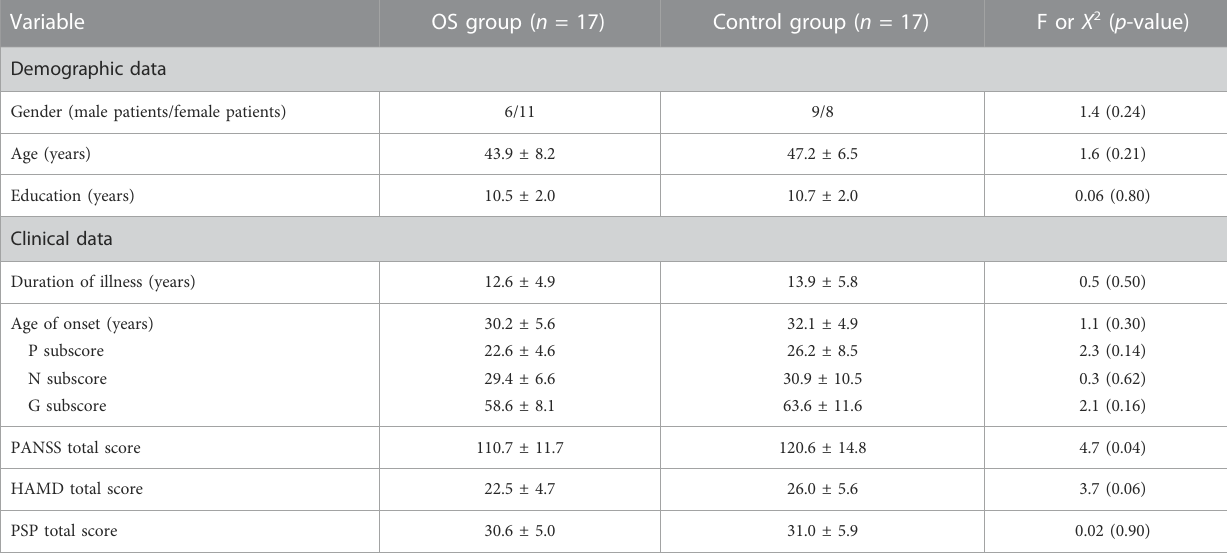
TABLE 1 Demographic and clinical characteristics in the combination therapy group (OS) and control group (mean ± SD).